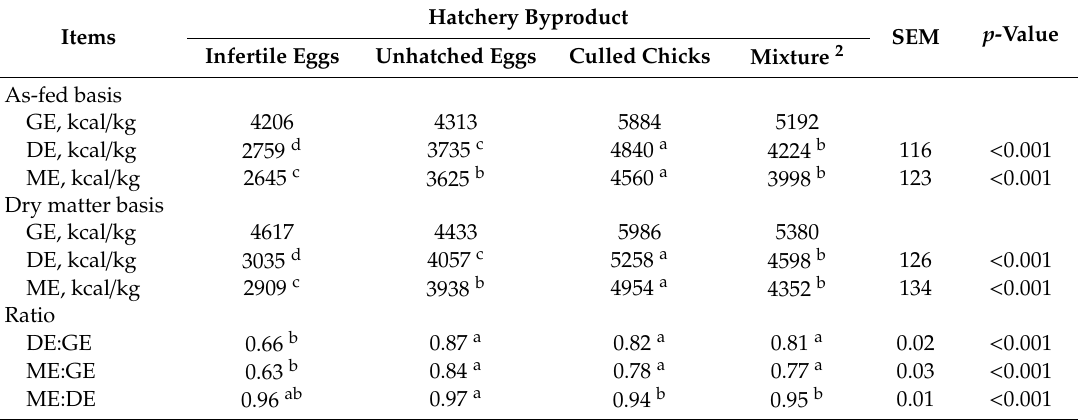
Table 5. Energy values for hatchery byproducts fed to nursery pigs (Experiment 1) 1